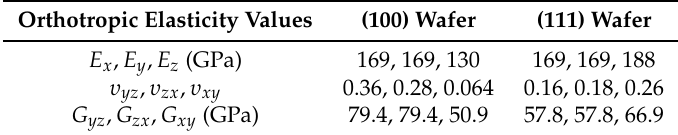
Table 1. Orthotropic elasticity values of (100) and (111) silicon